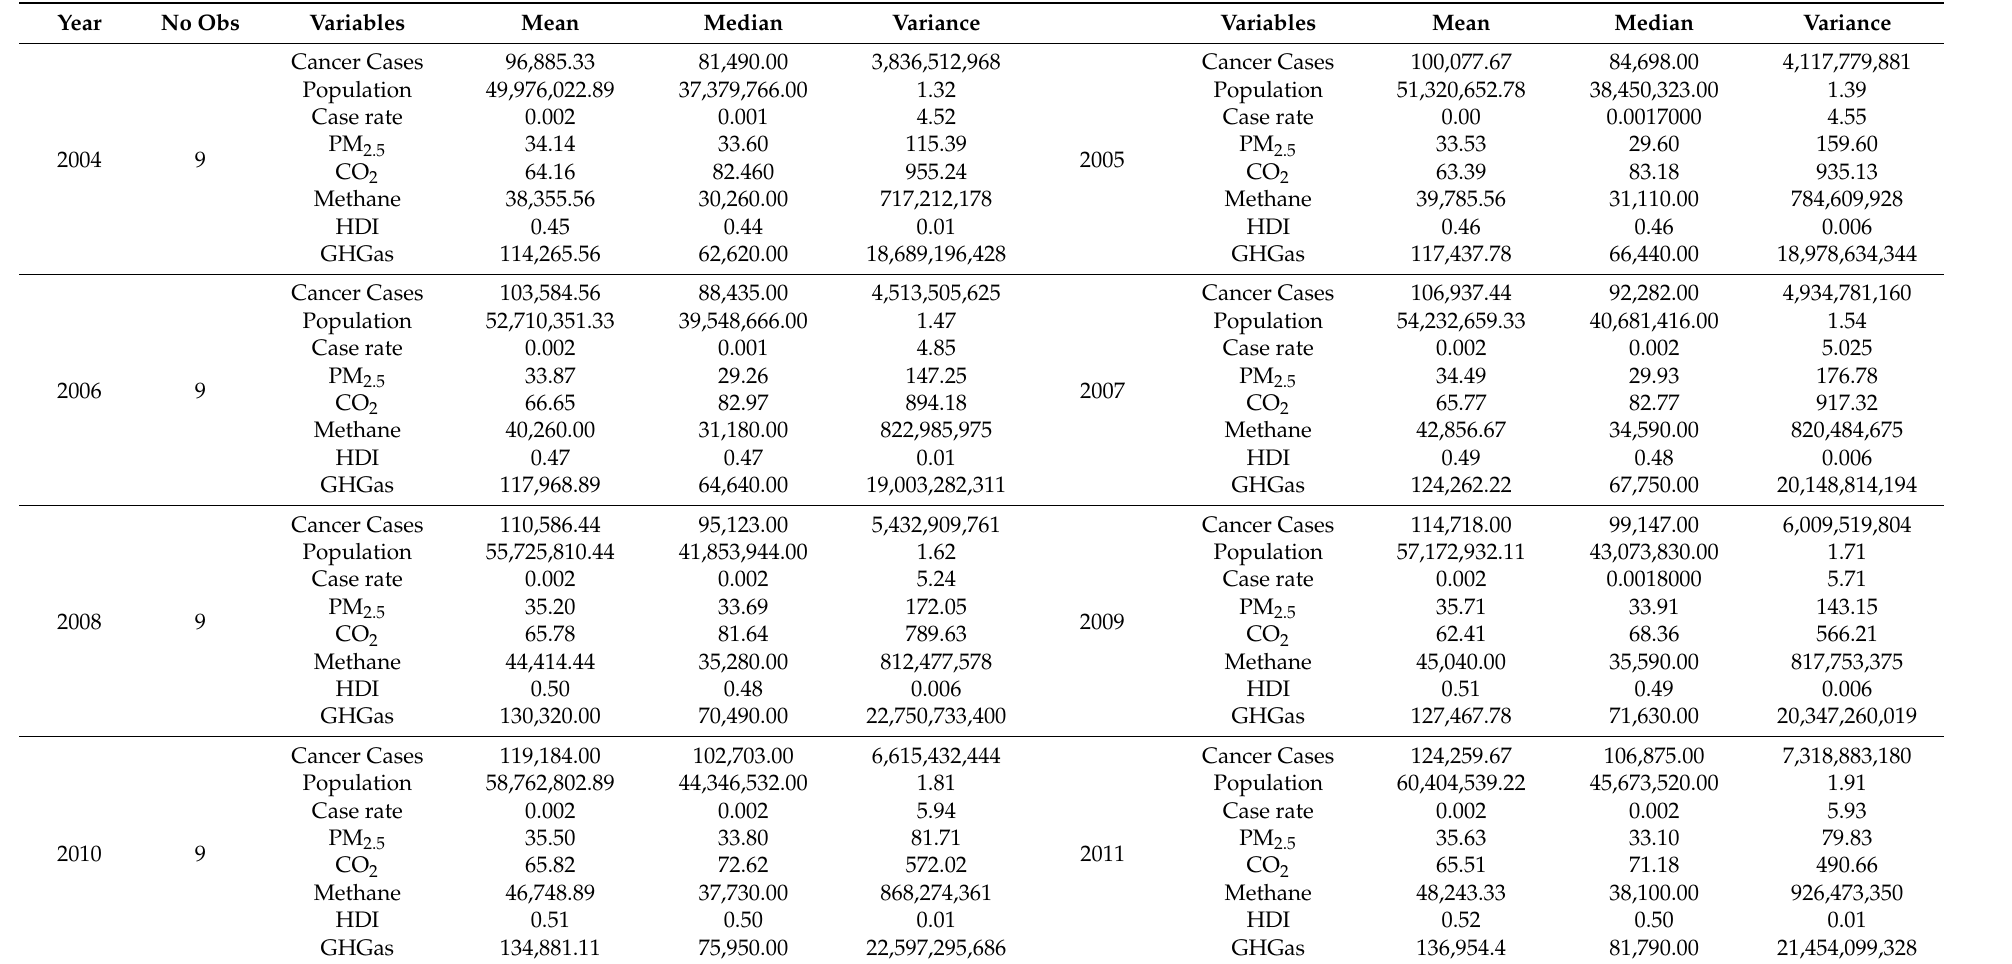
Table 2. Descriptive statistics by year 2005–2020. The MEANS Procedure across nine